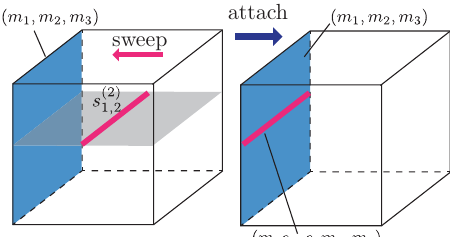
-string b , c 3 -wall 1,2,3